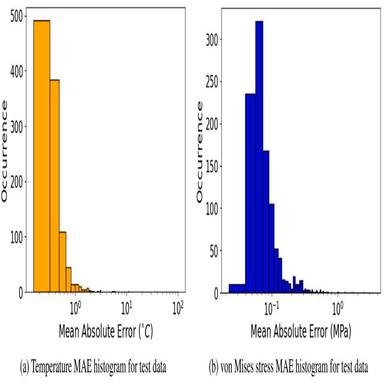
MAE histograms for temperature and von Mises stress.